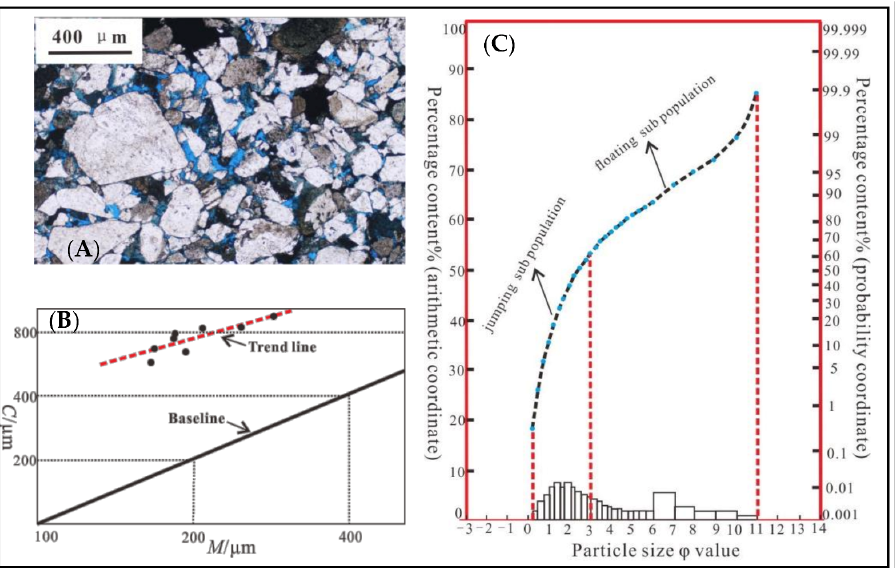
Figure 5. Characteristics of granular structure in well B1 (See Figure 1C for well location). ( A ) Core slice (3131 m) ( B ) C-M chart (Sample points in TST). ( C ) Probability Cumulative Curve (3330